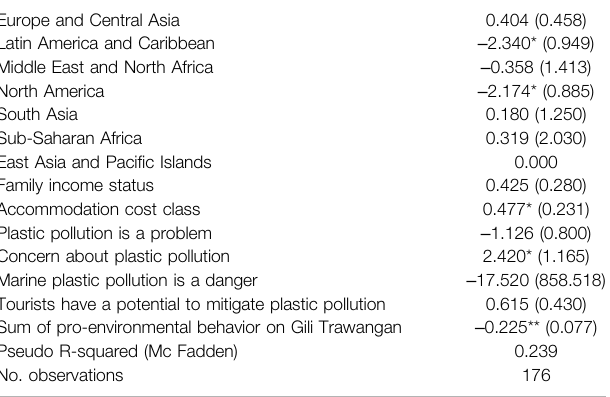
TABLE 5 | Regression results for accepted plastic bags (survey data). Europe and Central